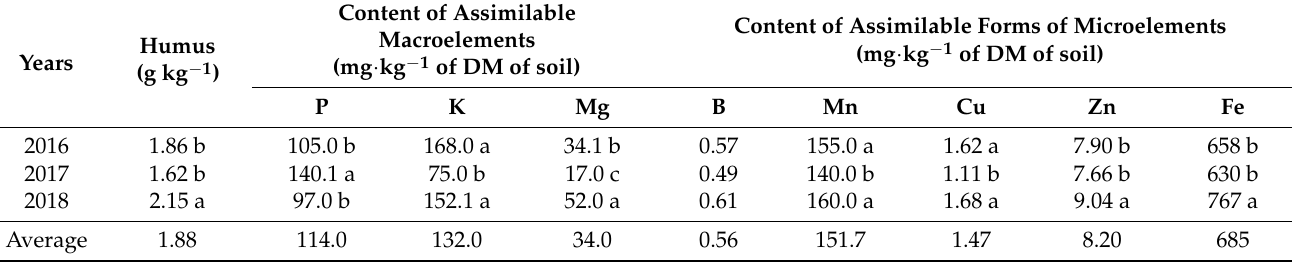
Table 2. Physical and chemical properties of soils in Parczew